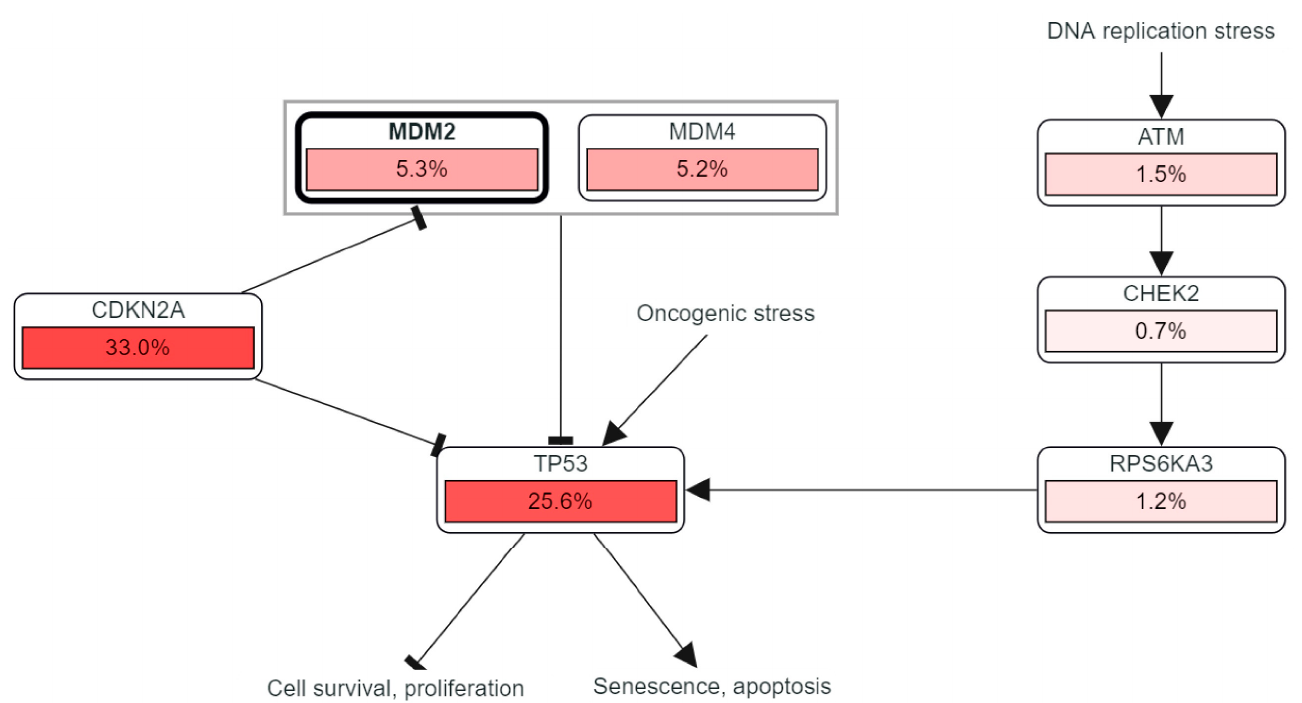
Figure 8. The interaction pathway of MDM2 with its correlated genes which are significantly associated with the progression of brain lower-grade glioma (LGG) cancer. The pathway has been depicted from cBioportal server after securing their cordial permission.